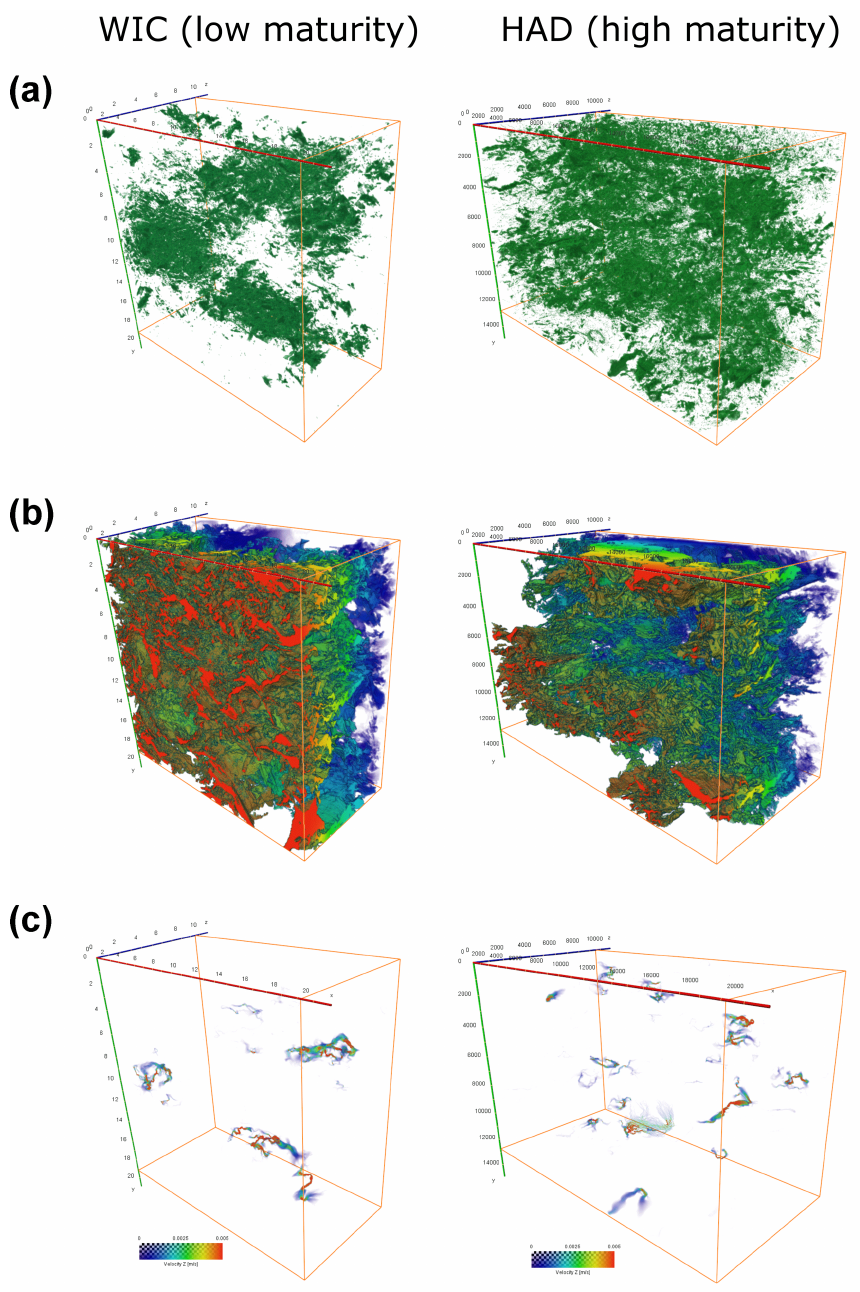
Figure 6. (a) Binarized pore volume. It was observed that small pores were mainly formed within organics and the clay mineral matrix. (b) Pressure fields in z direction resulting from GeoDict calculations. Jumps within the field were observed when throats become very thin or when a physical connectivity of the pores was not given. Regions where organics dominate show a continuous gradient. (c) Velocity field in z direction. Flow only takes place in regions that are dominated by pores. For a closeup of the flow field in a single pore cluster see Fig.